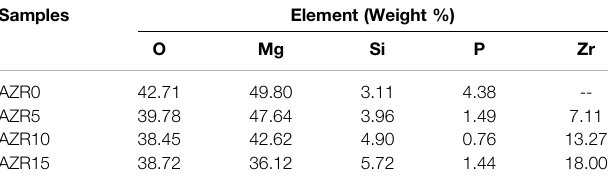
TABLE 2 | Elemental compositions of different samples analyzed by EDS.